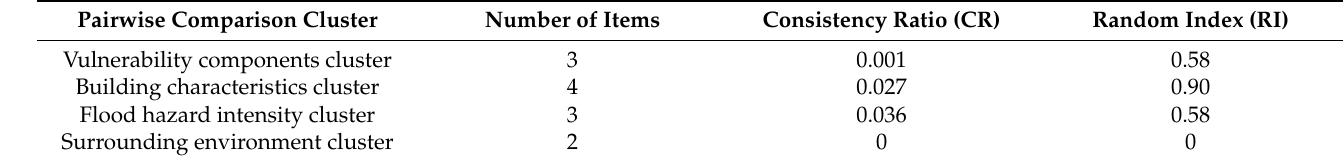
Figure 7. AHP hierarchical model of physical flood vulnerability indicators. Table 3. Inconsistences index result of the AHP